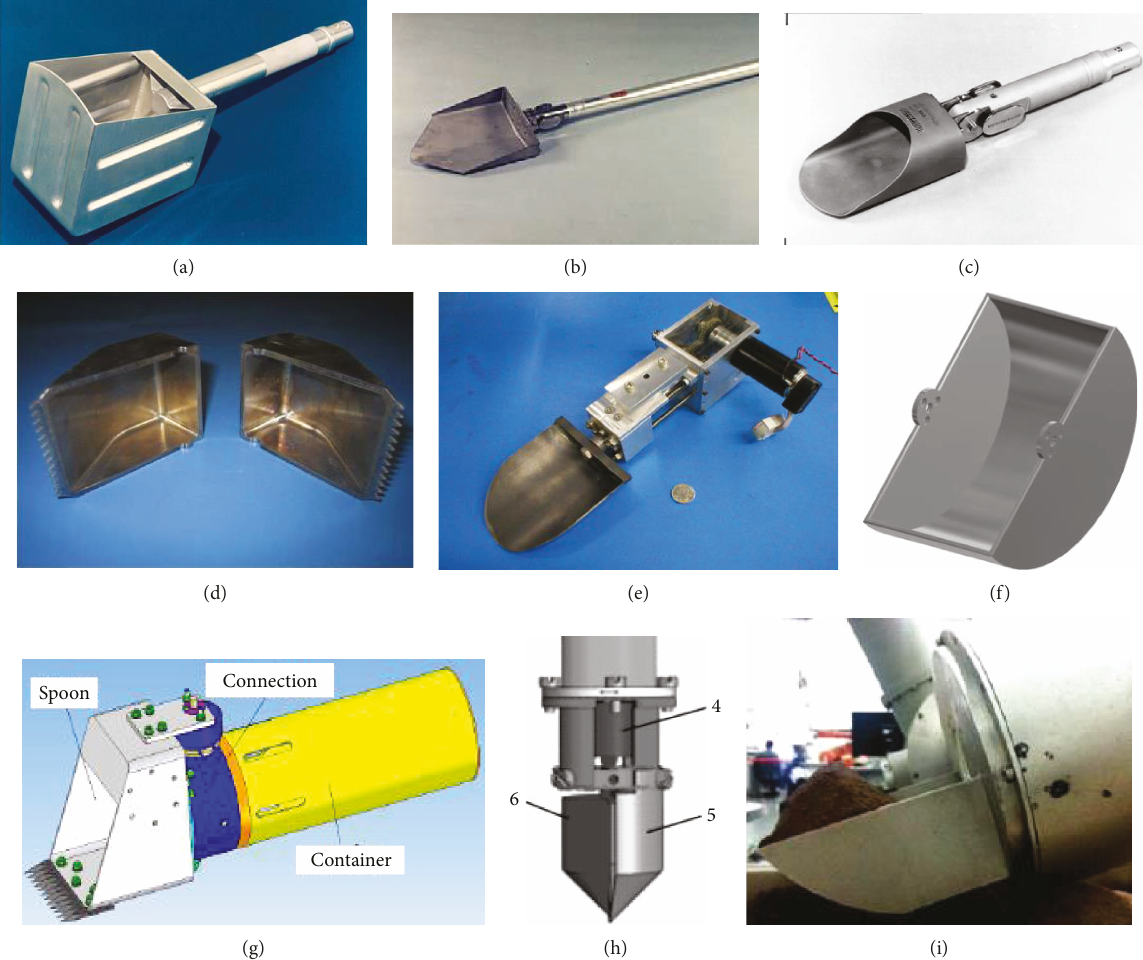
Figure 11: Planetary surface sampling devices around the world. (a – c) surface sampling equipment used in the Apollo Projects [17]; (d) SRR2k designed for the Mars 2018 project [18]; (e) digging equipment designed by Honeybee Corp. [19]; (f) sampling